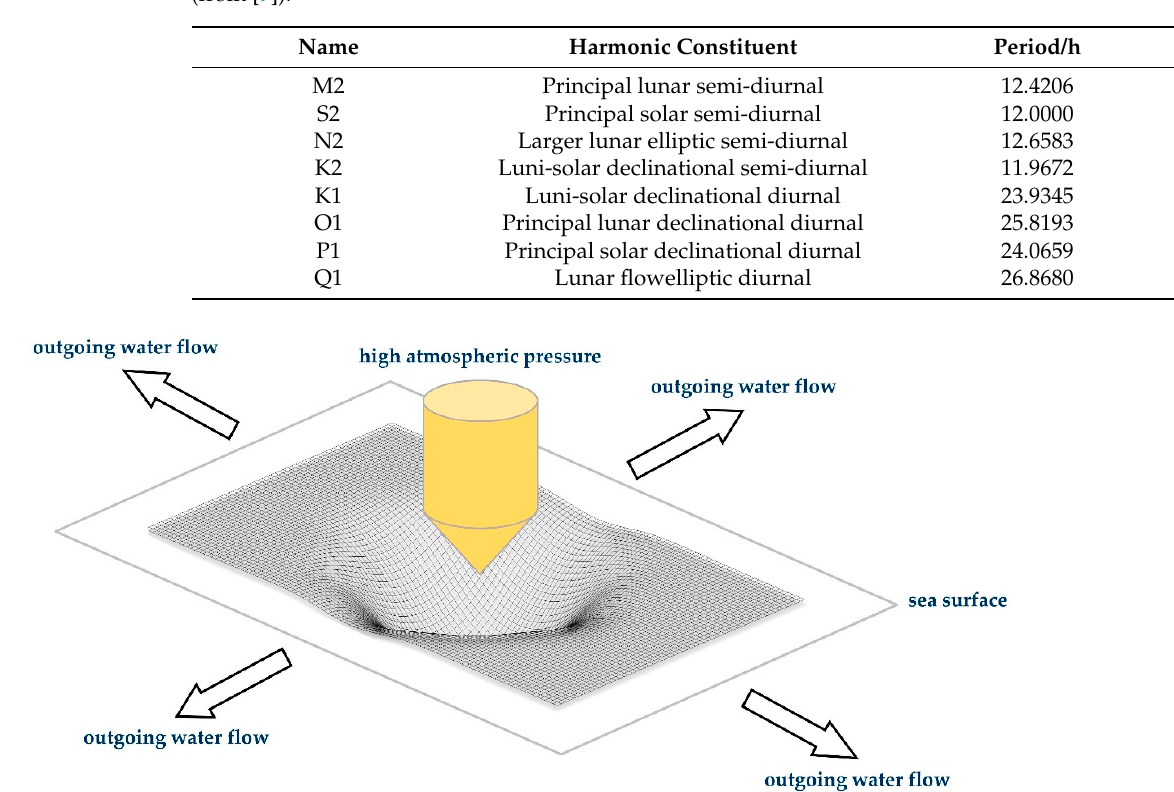
Figure 1. An increase in atmospheric pressure inducing a low meteorological tide (modified from [19]).